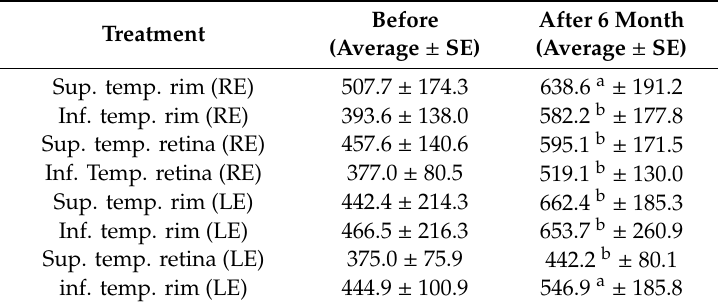
Table 7. Retinal blood flow of the superior temporal rim / retina and inferior temporal / retina after consumption of anthocyanins for 6 months in the left eye (LE) and right eye (RE). Before After 6 Month Treatment (Average ± SE) (Average ±